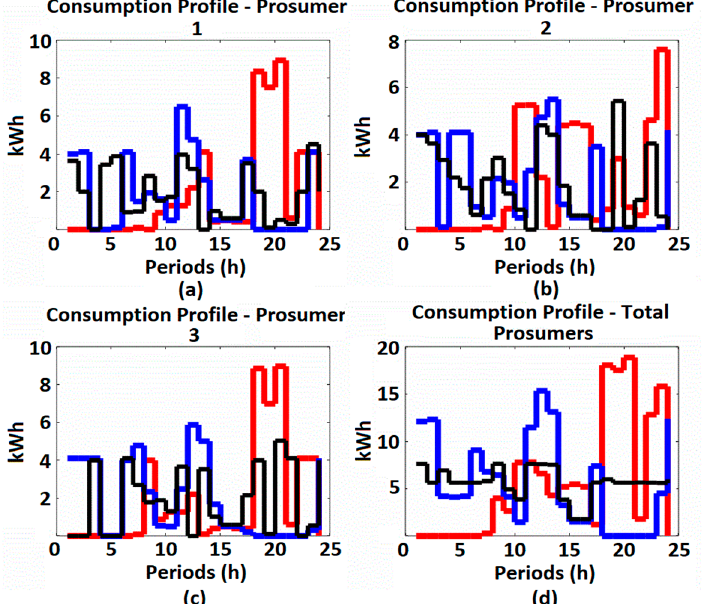
Figure 3. Habitual consumption profile and profiles of optimal consumption without and with the improvement of the LF. ( a ) Consumption profiles for prosumer 1; ( b ) Consumption profiles for prosumer 2; ( c ) Consumption profiles for prosumer 3; and ( d ) Consumption profiles for all prosumers.